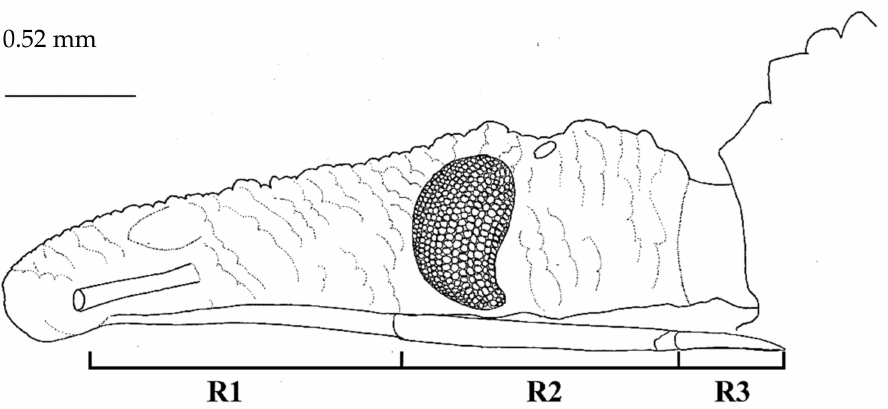
Figure 4. Belminus santosmalletae sp. n. Schematic outline of the detail of the head in lateral view showing the visible labium segments ( R1 , R2 , and R3 ), depicting the first segment ( R1 ) not reaching the anterior border of the